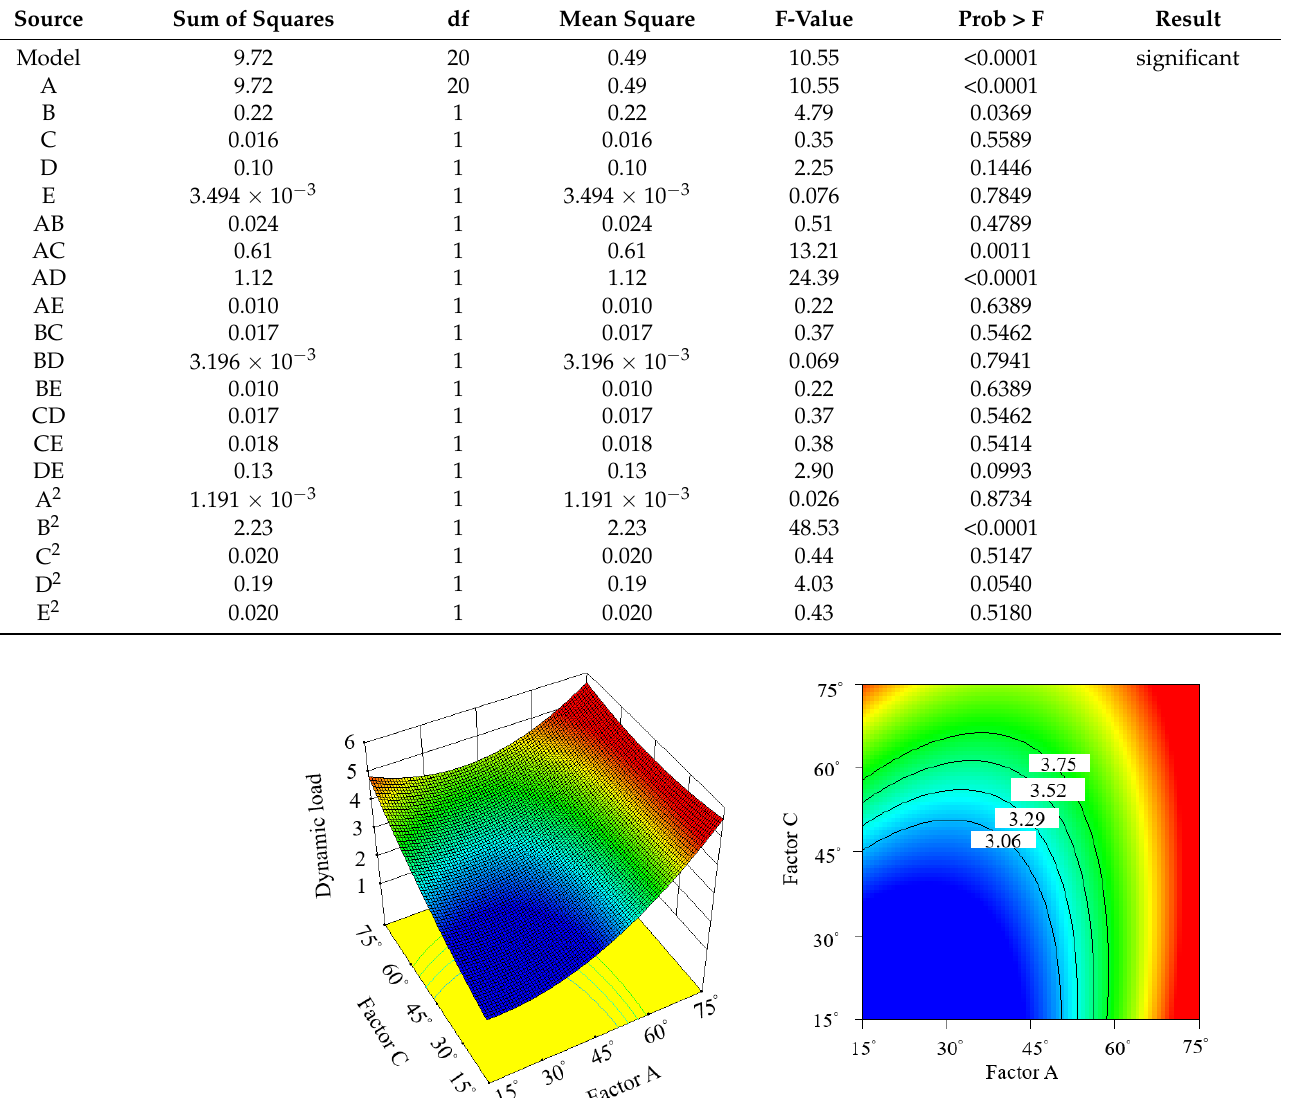
Table 5. Significance test of the dynamic load regression model.